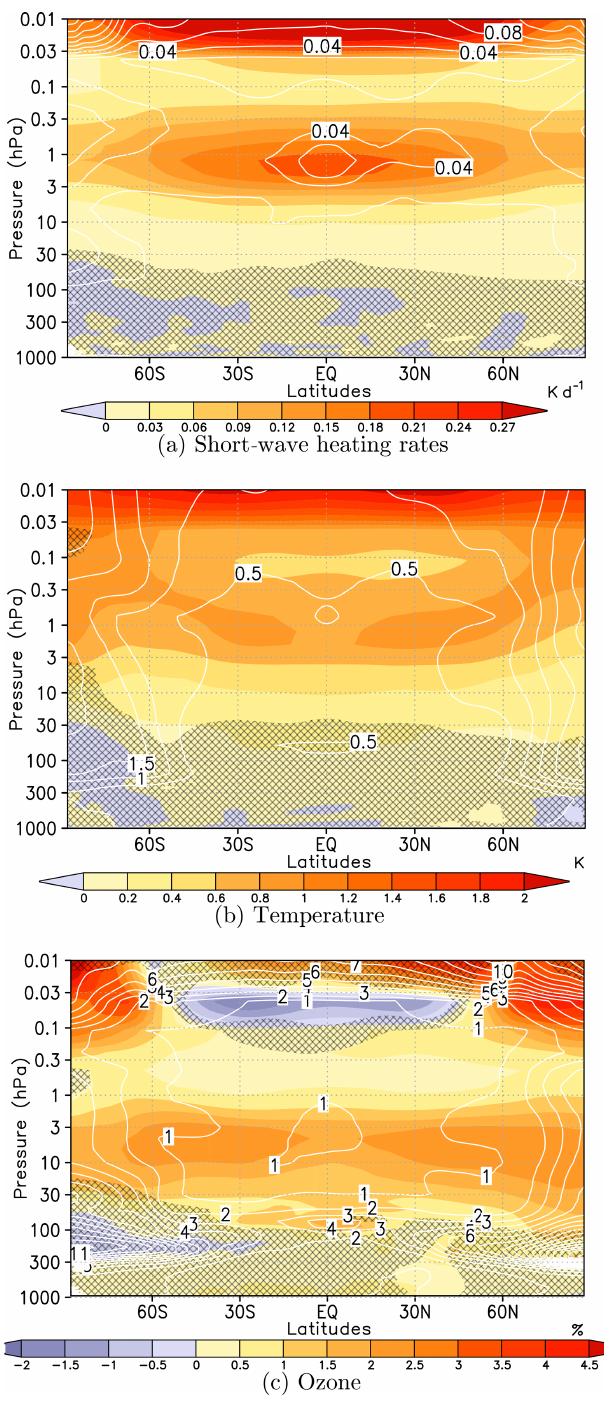
Figure 3. Annual mean 11-year solar cycle response (shaded) and signal variance (white contours) in terms of the solar response an- nual standard deviation for SW heating rates (a) , temperature (b) , and ozone mixing ratios (c) . Solar response derived as ensemble mean over both models and all SSI data sets; solar minimum SSI based on ATLAS-3 reference state. The grey hatching masks areas where signal or ratio of explained variance does not pass a test for statistical significance ( p >